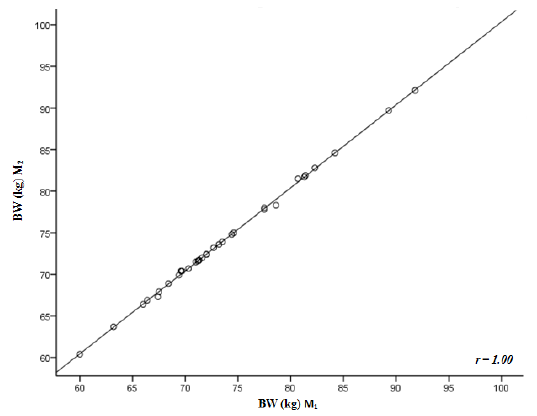
Figure 1. Correlation between the values of param- eters measured by Tanita before and after the intake of fluids – body weight (kg)